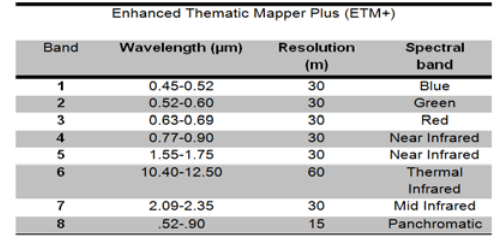
Figure 6: Example of a nomination dossier and maps. © Silk Roads